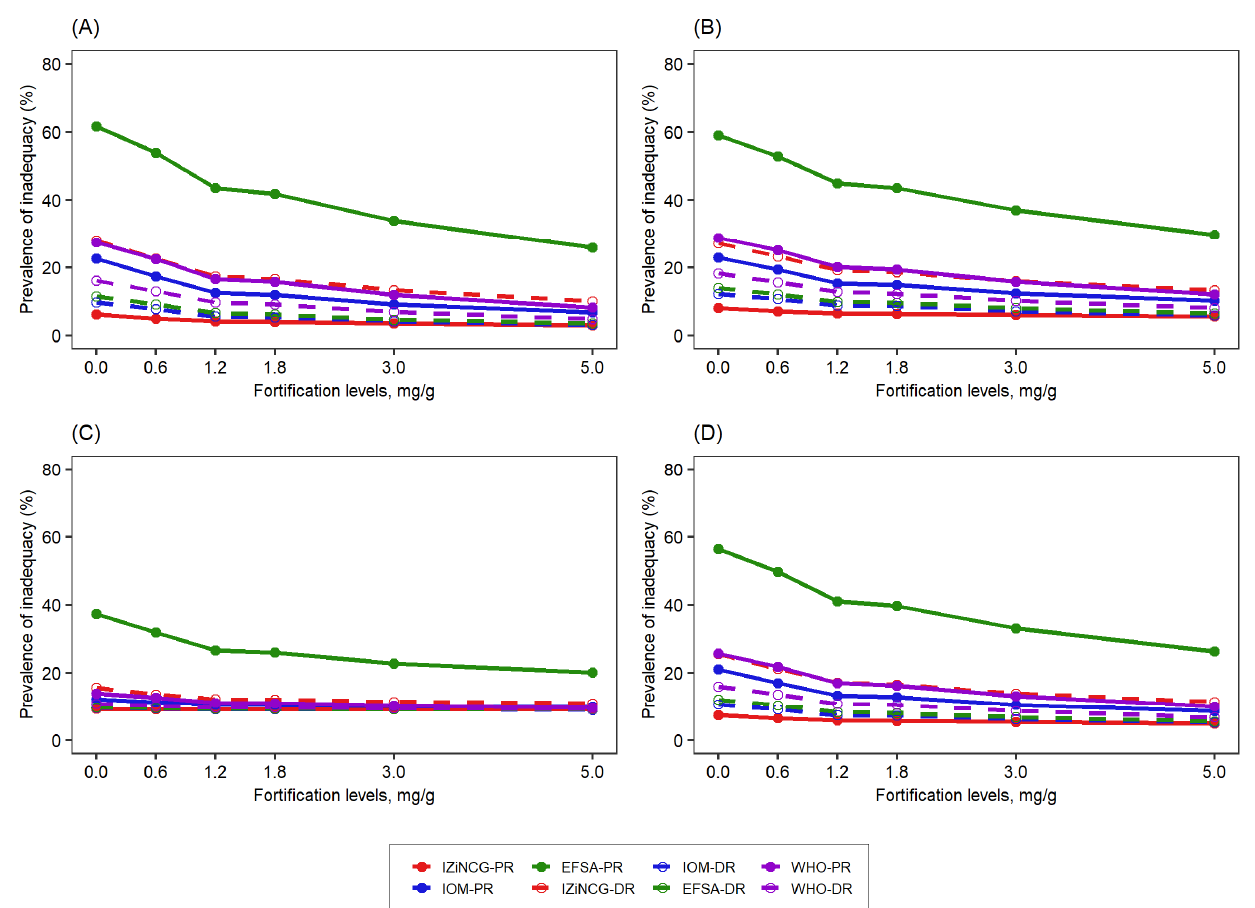
Figure 5. Effect of the level of zinc fortification of bouillon cube (mg zinc/g bouillon cube) on the prevalence of inadequate zinc intake among children in the presence of wheat flour fortification (95 mg zinc/kg flour) according to different NRVs. (A) South ‐ macro region, (B) North macro ‐ region, (C)